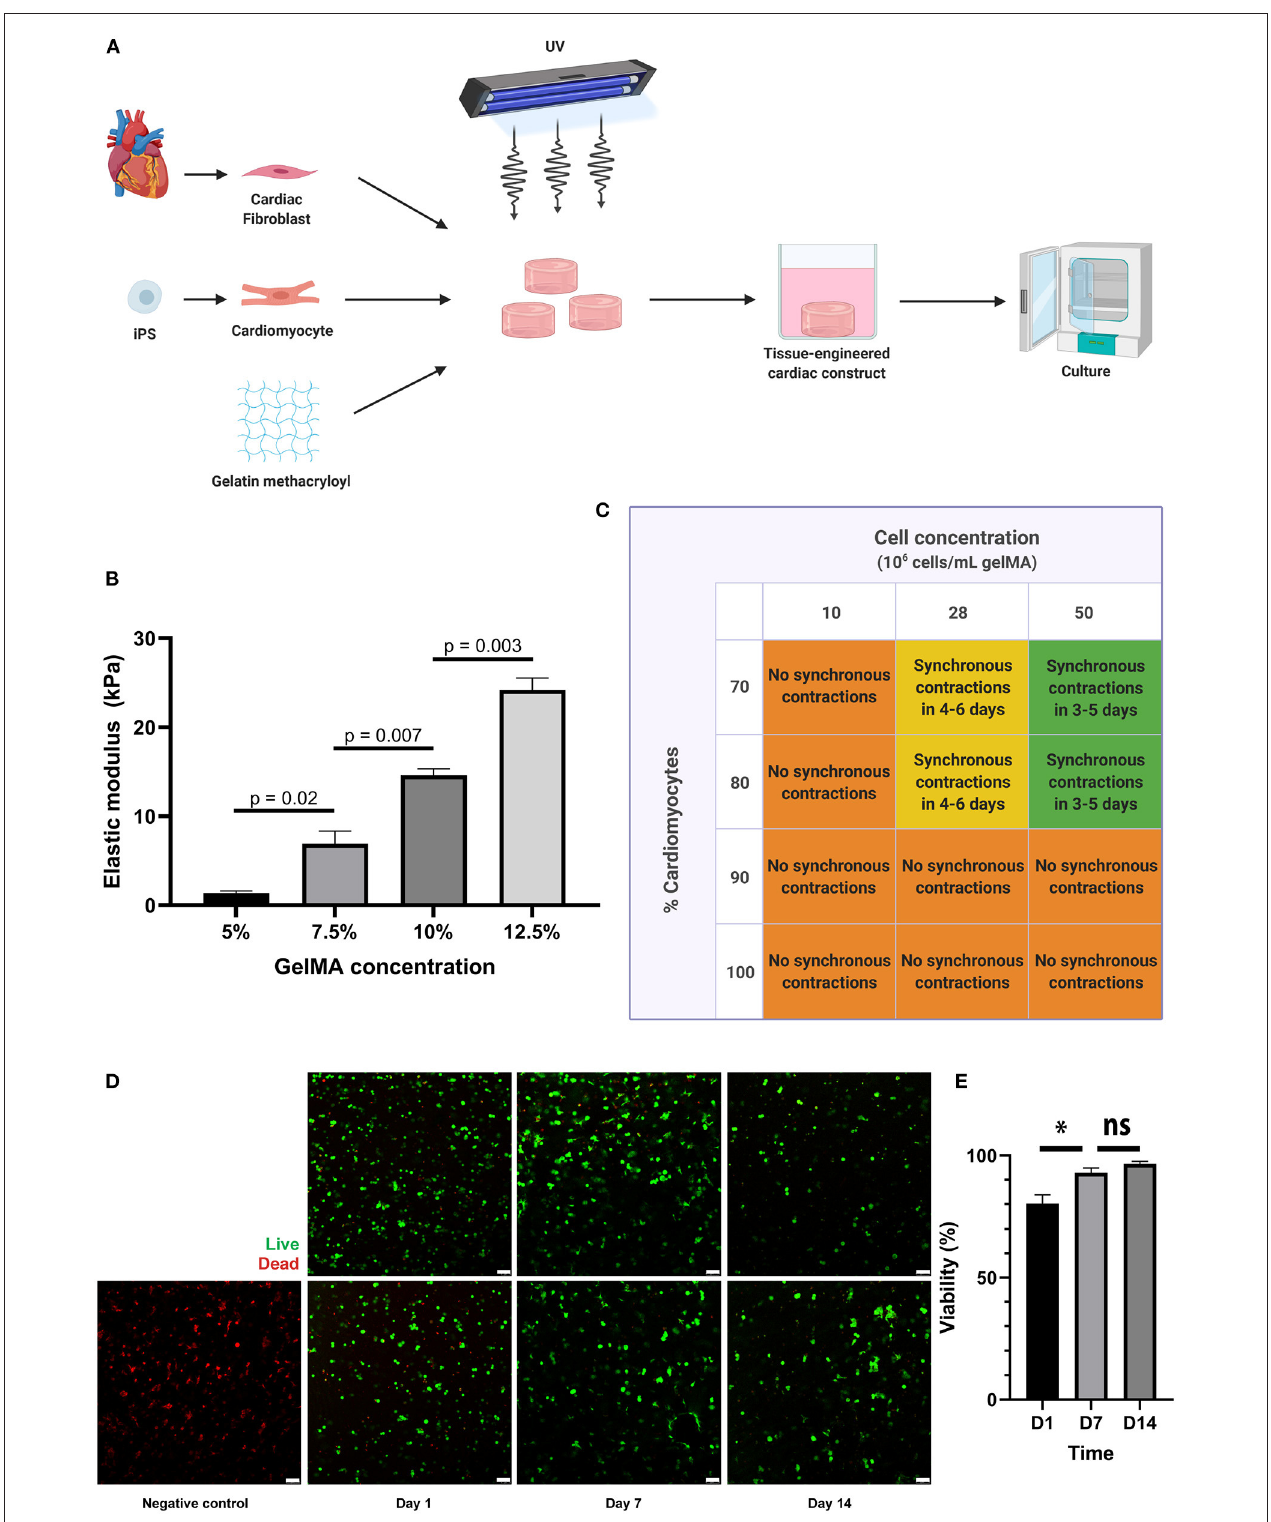
FIGURE 1 | A 3D co-culture of cardiac fibroblasts and iPS-derived cardiomyocytes in a GelMA hydrogel results in a functional cardiac tissue construct. (A) Schematic overview of the tissue engineering process. Primary cardiac fibroblasts and iPS-CM were suspended in a GelMA polymer solution and subsequently cross-linked